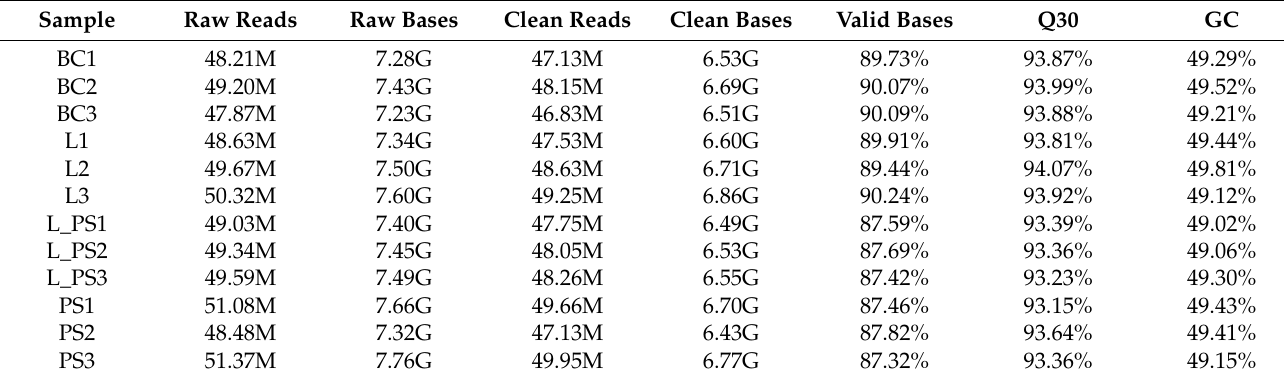
Table 3. Summary of RNA-sequencing results and quality data output.